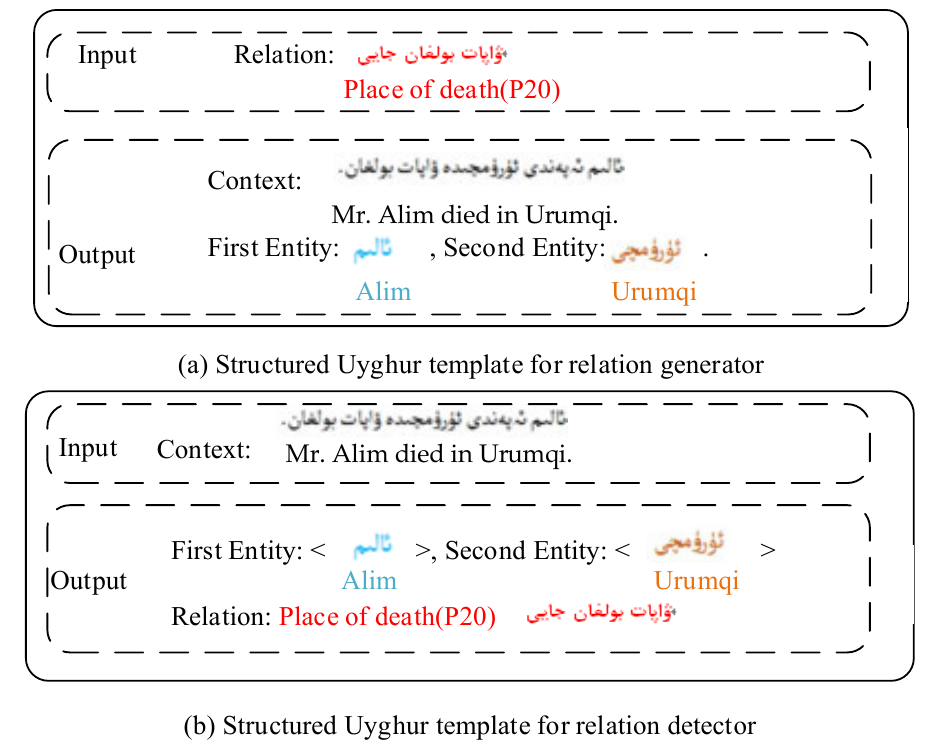
Figure 1. The Uyghur Relation Prompt structured templates. Table 3. Common symbolic descriptions in relationship